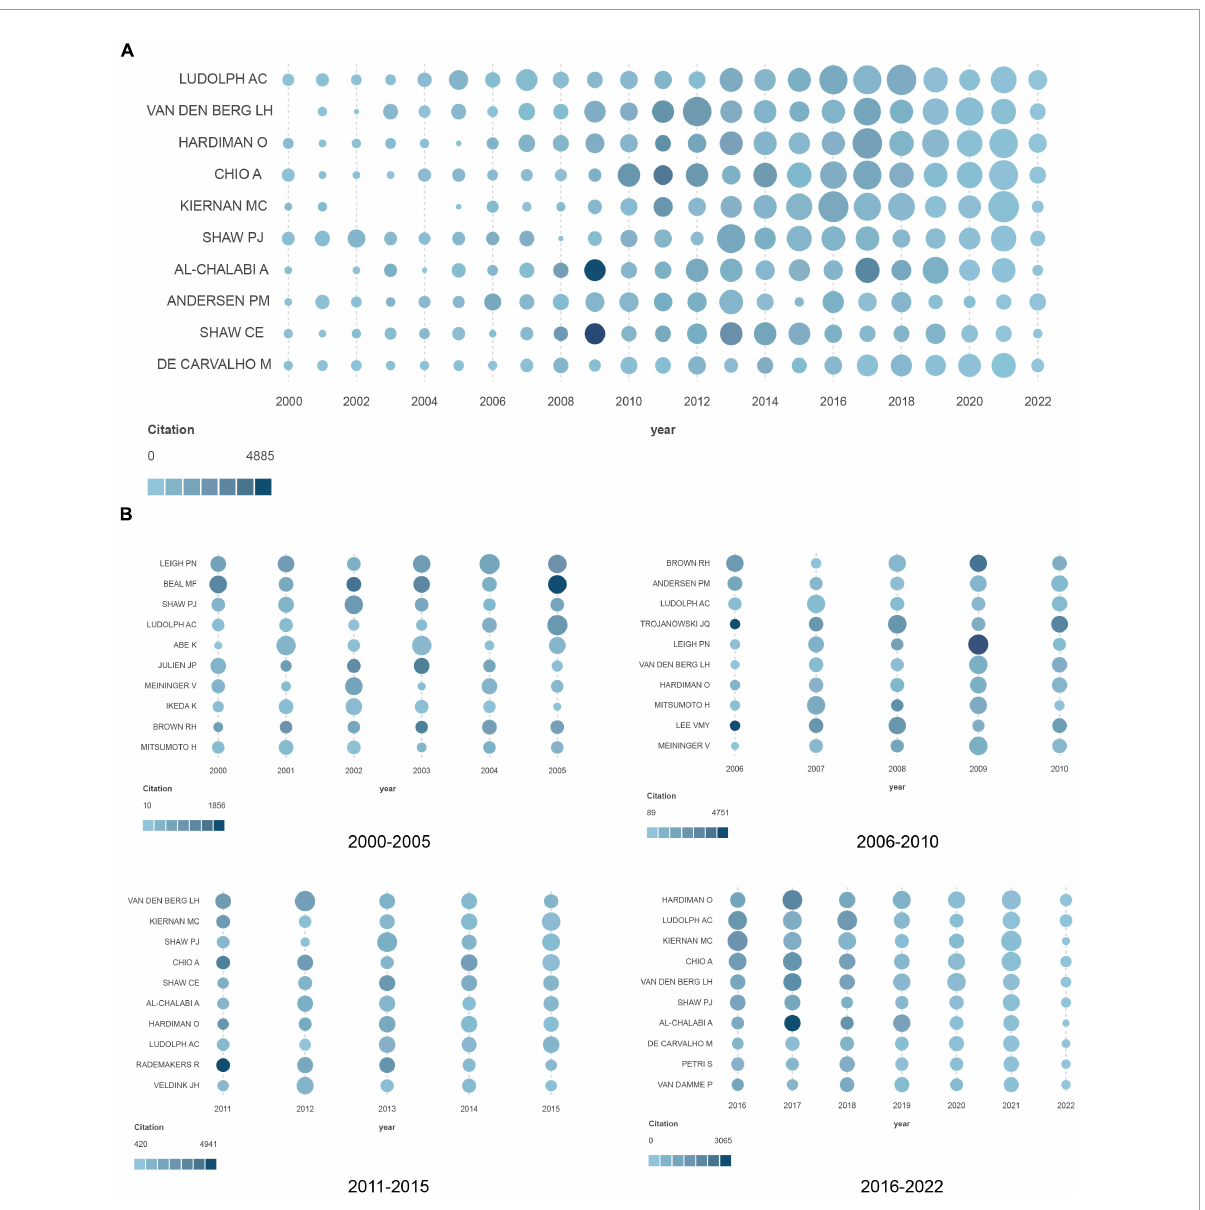
the same algorithm, and keywords were classified into clusters for each period. Owing to the update of the content, the meaning of the same color cluster was not consistent across different